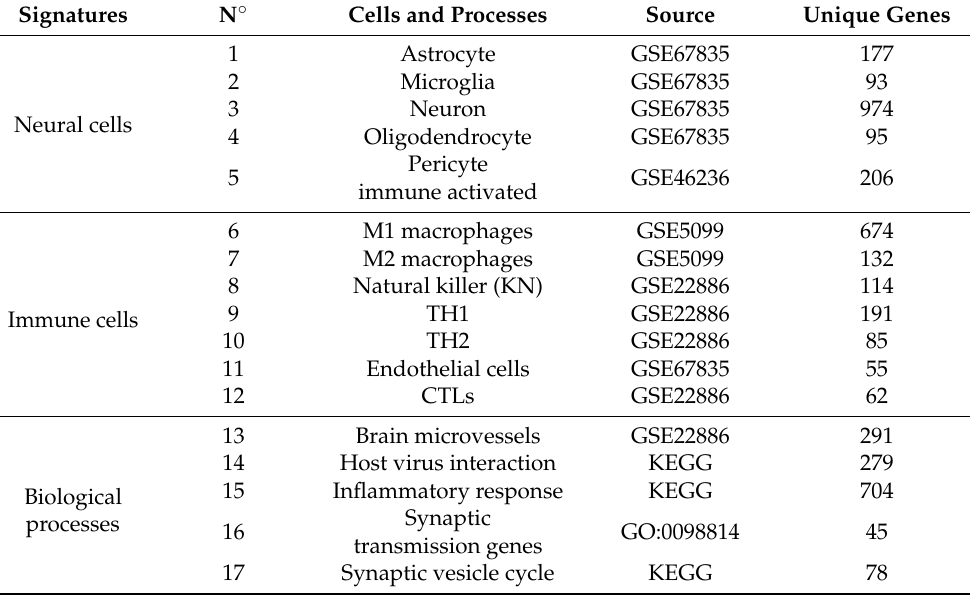
Table 3. Neuro ‐ immune cells signature.